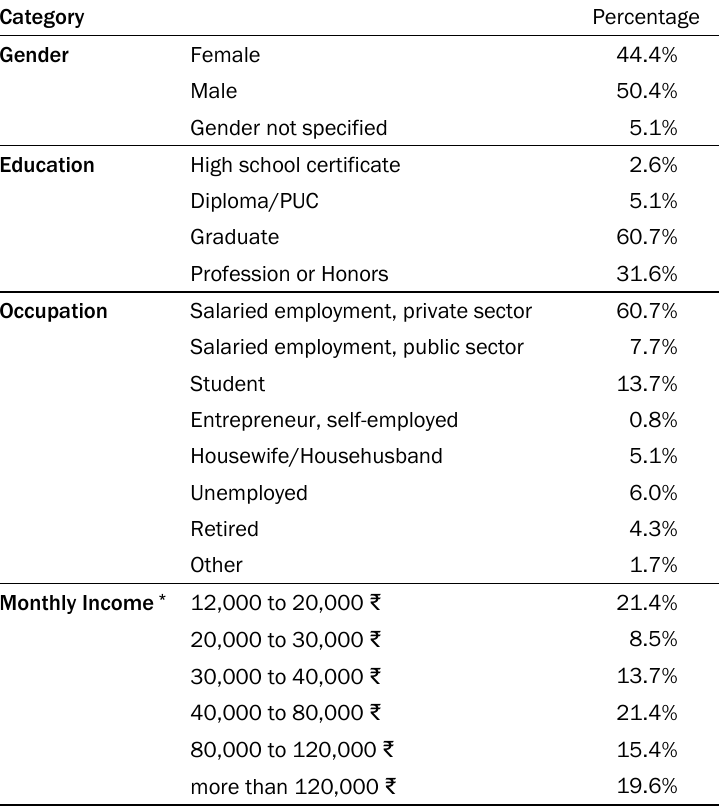
Table 1. Demographics of Online Survey Respondents ( N =117)